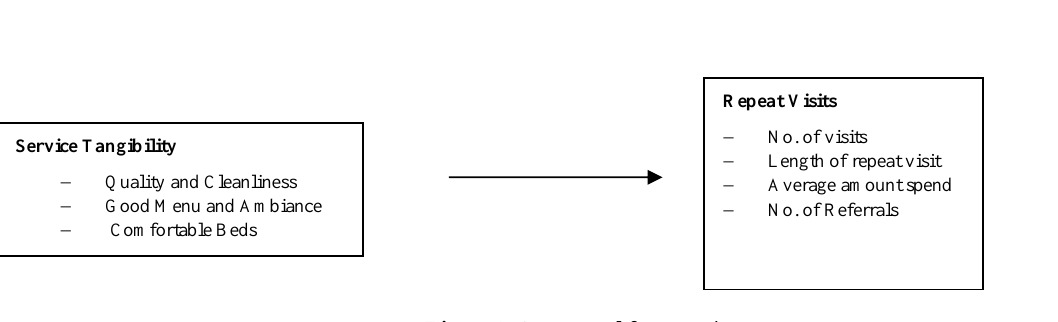
Figure 1: Conceptual